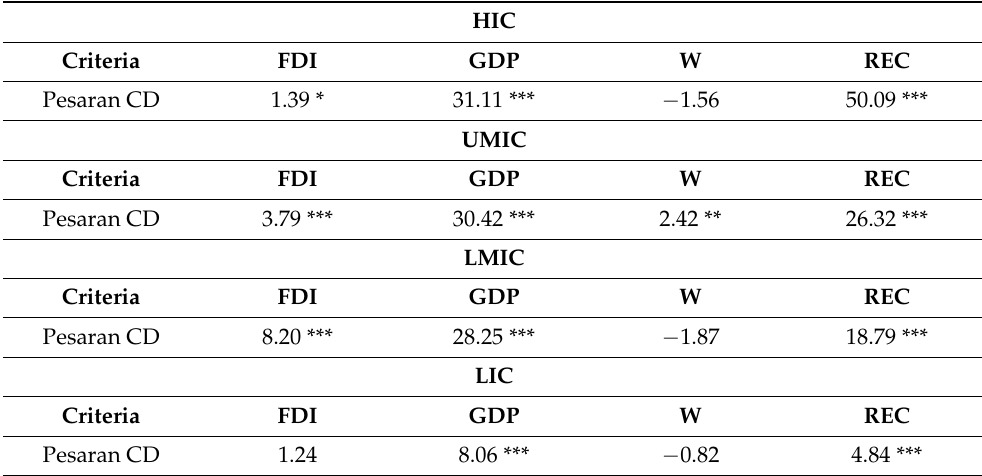
Table 2. Cross-Sectional Dependency Tests.